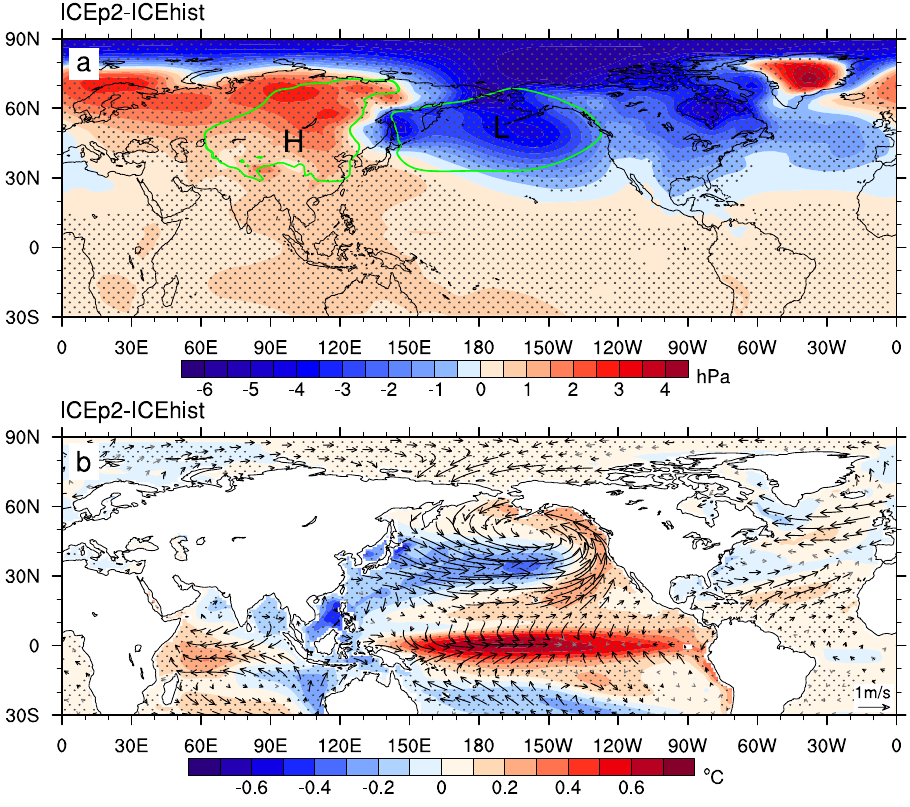
Fig.2|Changesinwintersea-levelpressure(SLP),andsea-surfacetemperature (SST) and near-surface winds induced by the seasonally ice-free Arctic. a Difference in SLP (hPa) between the time-slice-coupled model experiments with fi xed Arctic sea ice during 2080 – 2099 (ICEp2) and during 1980 – 1999 (ICEhist). Contours outline the climatological Aleutian Low and Siberian High based on